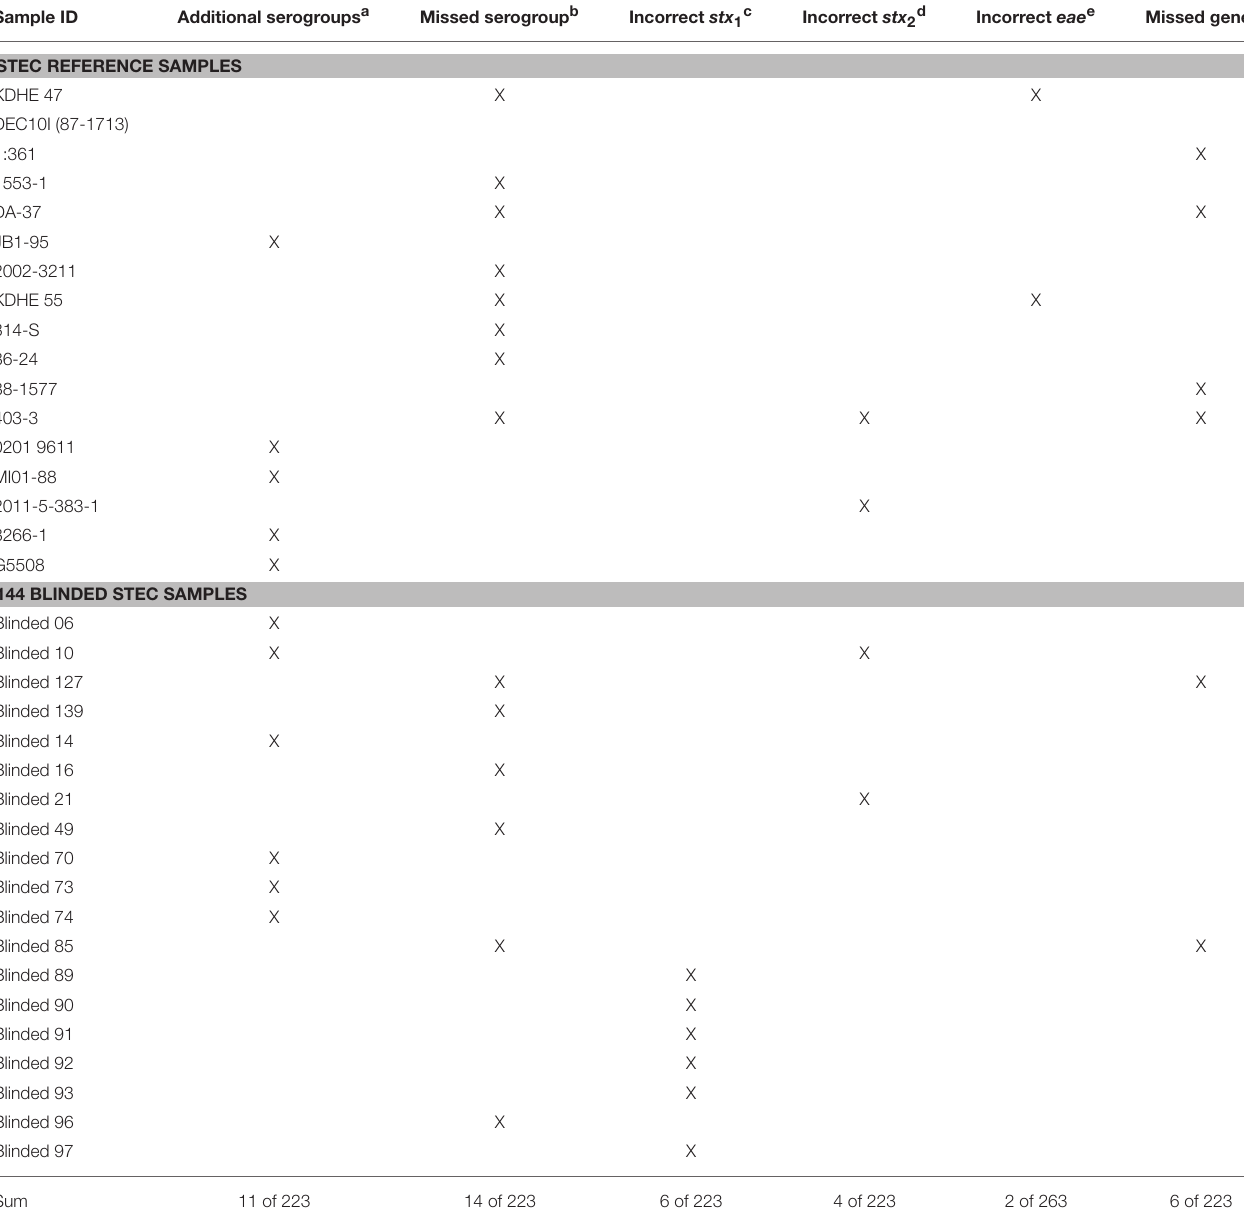
TABLE 3 | Detailed examination of incorrect